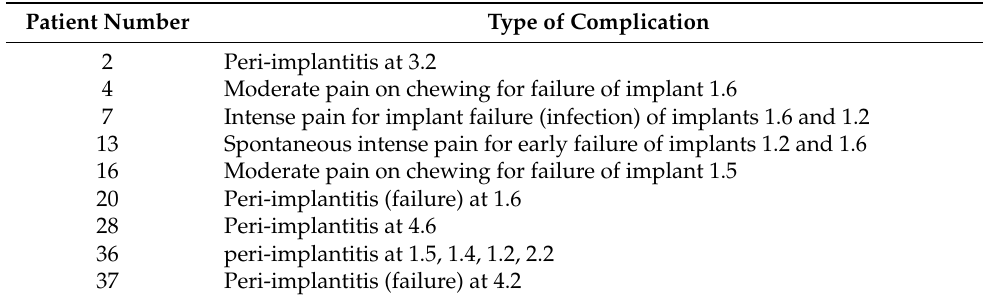
Table 6. Description of biological complications occurred up to seventh year in